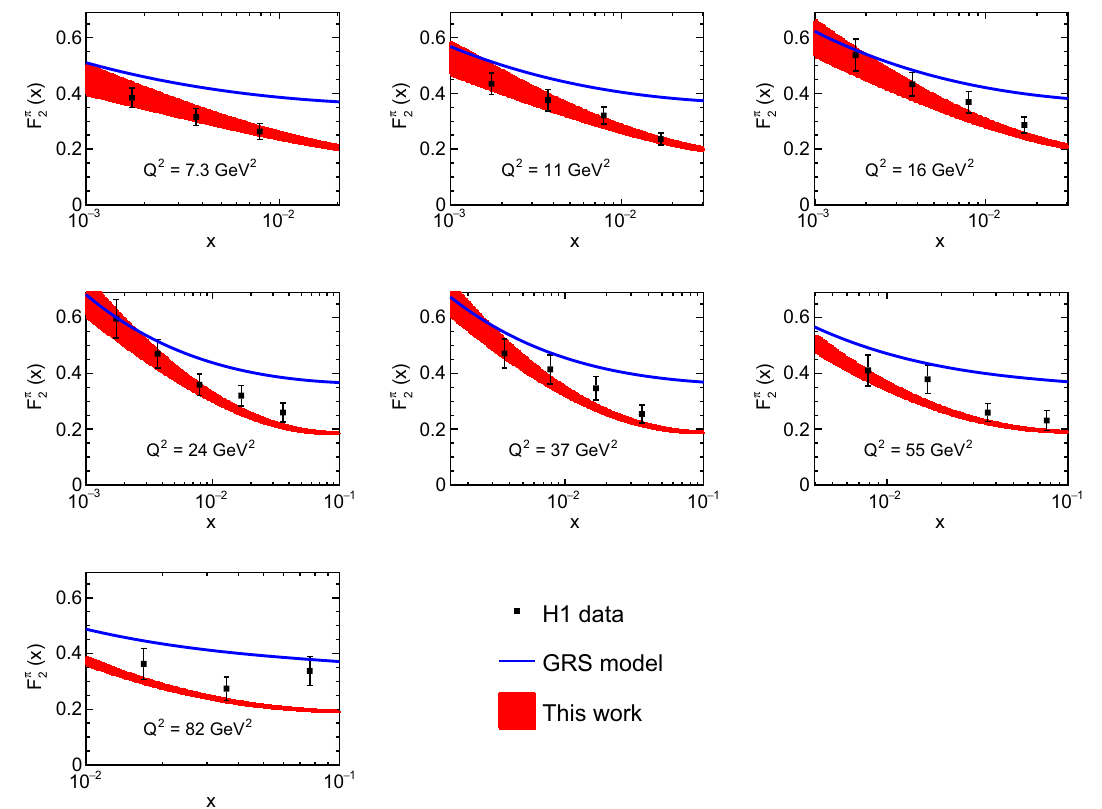
( x , Q 2 ) compared with H1 data [30], and GRS model predictions [31]. The error bands of this work Fig. 4 Our predicted structure function F π 2 show the 3 σ uncertainties of the structure